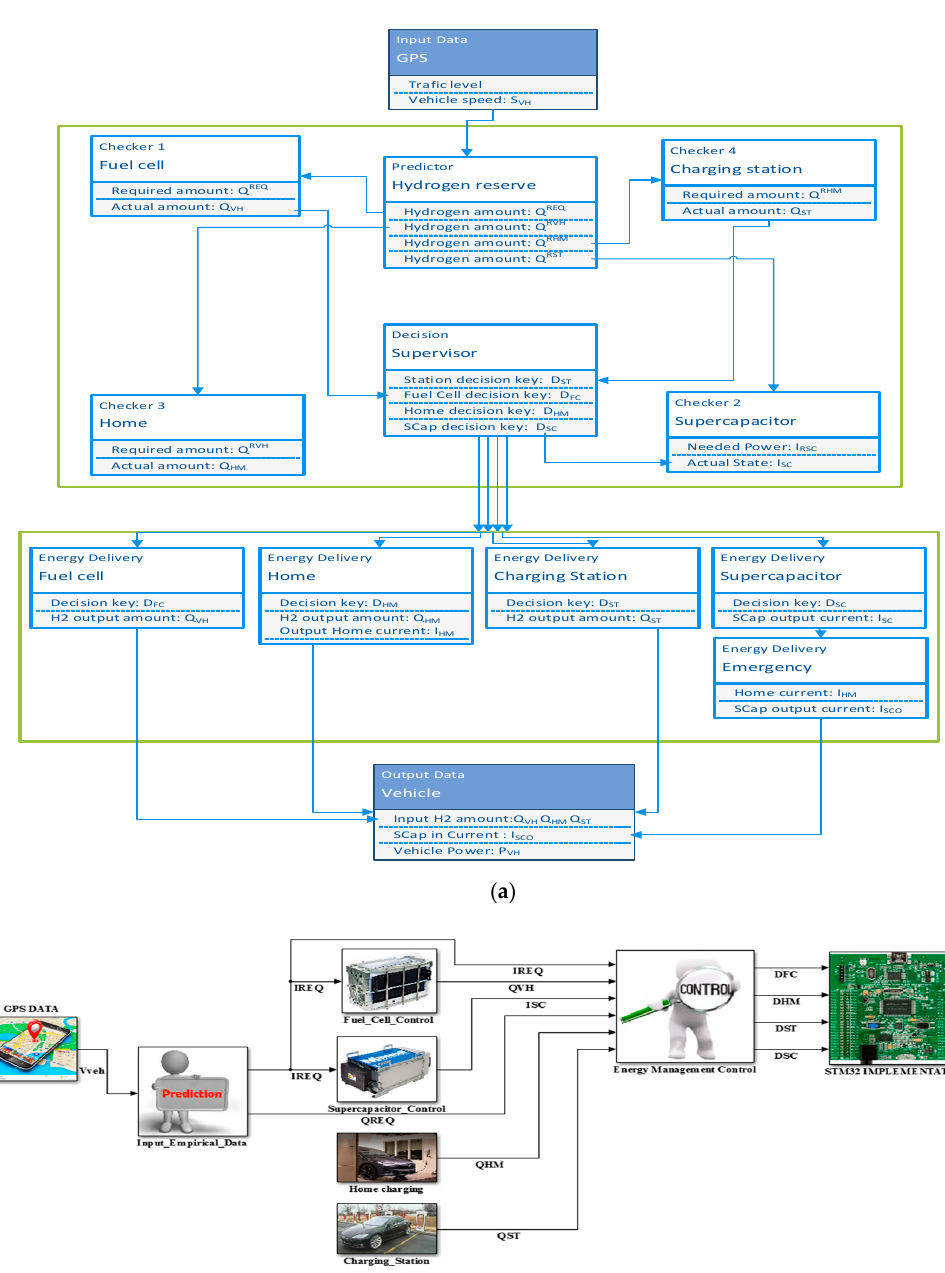
Figure 6. NZE-HEVSim tool simulation: ( a ) Simulation diagram and ( b ) MATLAB/Simulink model.